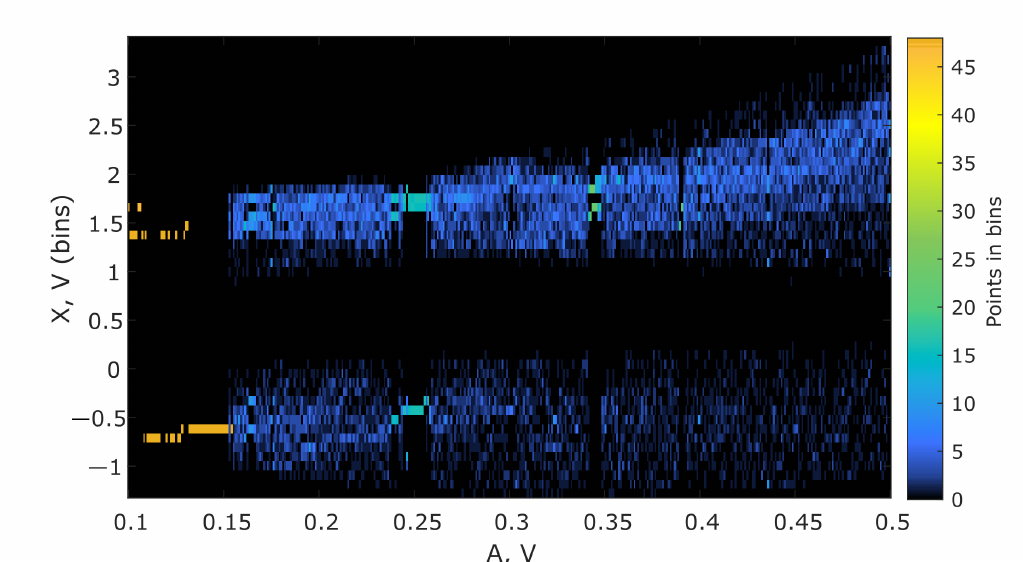
Figure 10. Spectral diagram of the Duffing oscillator fed with input sine wave of frequency f = 1700 Hz and amplitude A ,V. One may see that that the energy of low-frequency oscillations in the periodic mode is 20 dB lower (turquoise and yellow regions) than in the chaotic mode (red regions). This spectral property is used for constructing an analog oscillations mode detector—see Section 2.2.4.